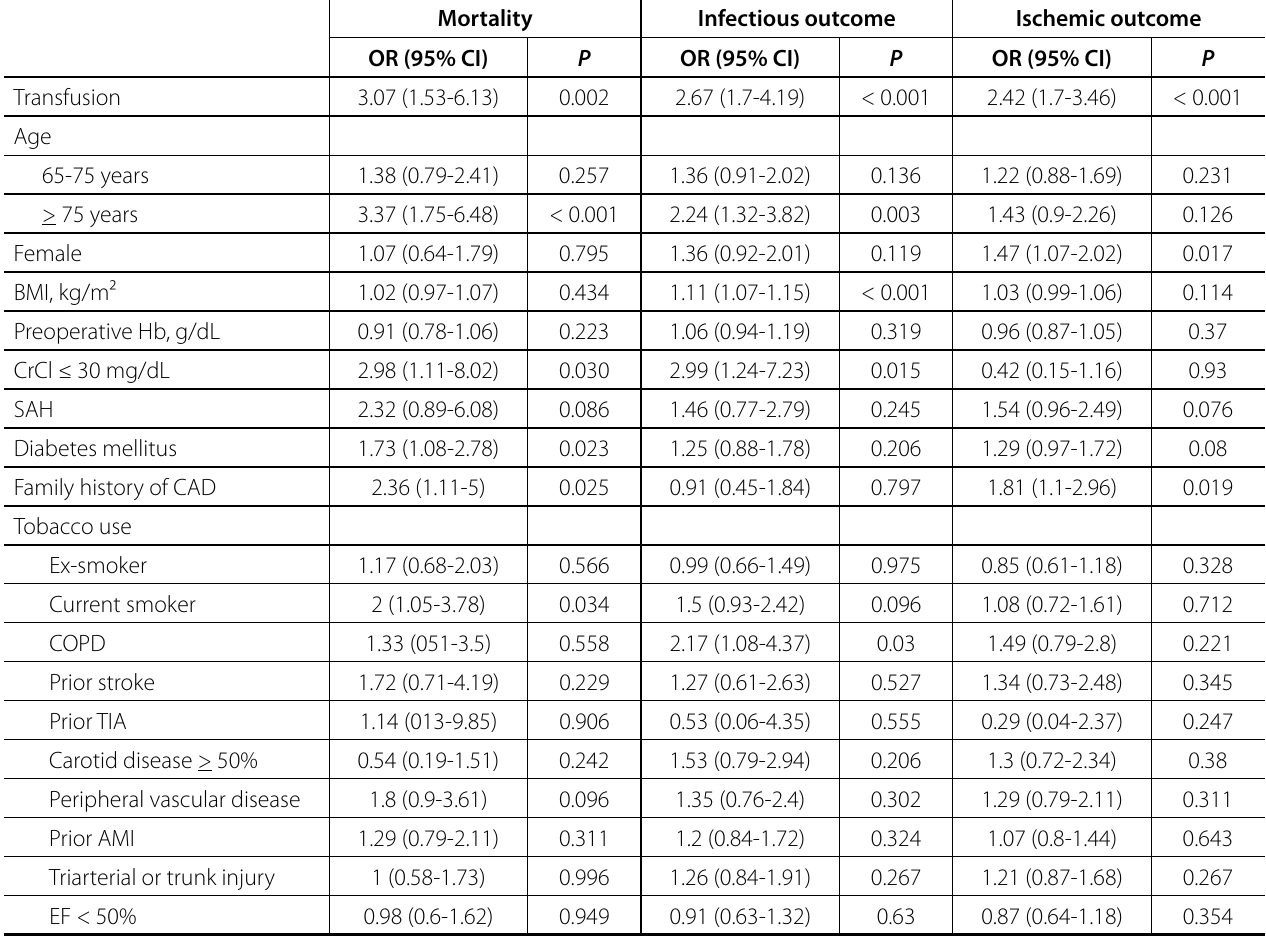
Table 3. Multivariate logistic analysis for the prediction of three co-primary